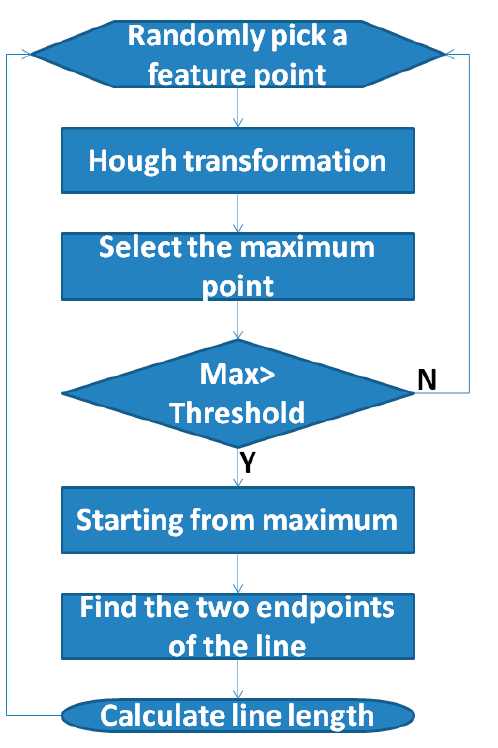
Figure 9. Progressive Probabilistic Hough Transform detects straight-line data.